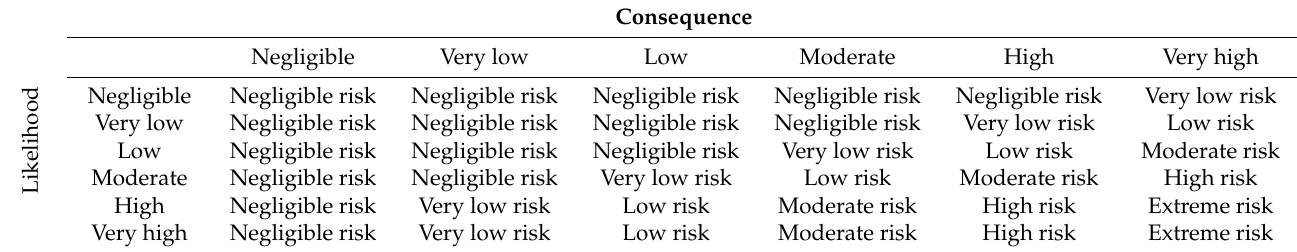
Table 4. Matrix of the risk level of each identified hazard associated with “cause more